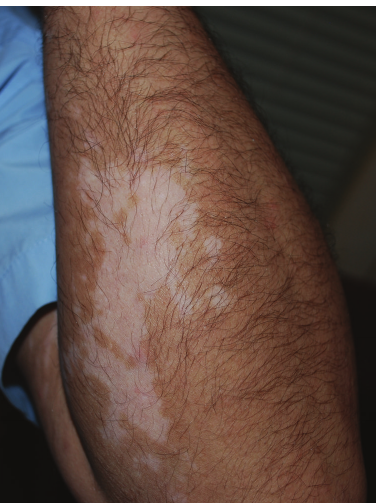
Figure 2: Vitiligo patches on left arm distant from the location of DPCP